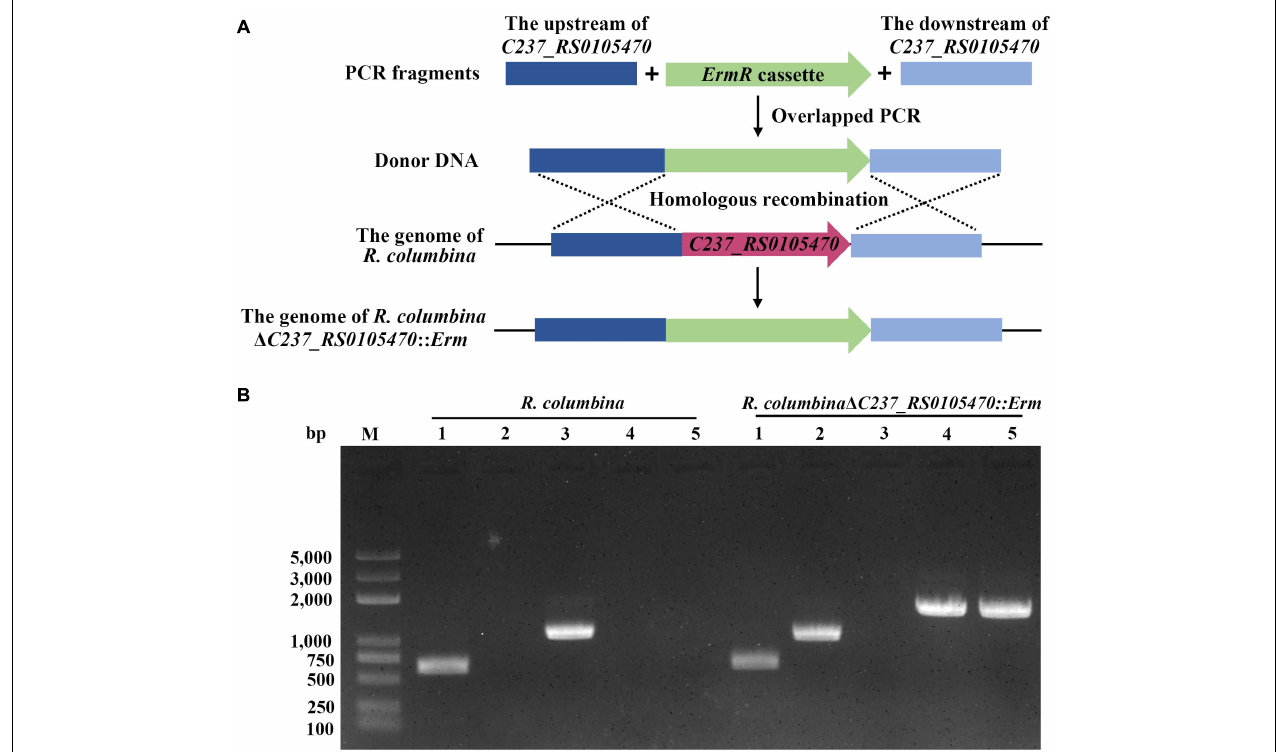
FIGURE 1 | Verification of the mutant strain R. columbina (cid:49) C237_RS0105470 :: Erm . (A) Schematic diagram of donor DNA preparation and gene deletion based on natural transformation. (B) The identification of the R. columbina (cid:49) C237_RS0105470:Erm mutant strain by PCR. Lane M, MD103 DNA marker (BioMed, Beijing, China). Lane 1, the 16S rRNA was amplified from wild-type R. columbina and the mutant strain R. columbina (cid:49) C237_RS0105470 :: Erm using the primers RC-16S rRNA P1 and RC-16S rRNA P2. Lane 2, the erythromycin resistance cassette was amplified from wild-type R. columbina and the mutant